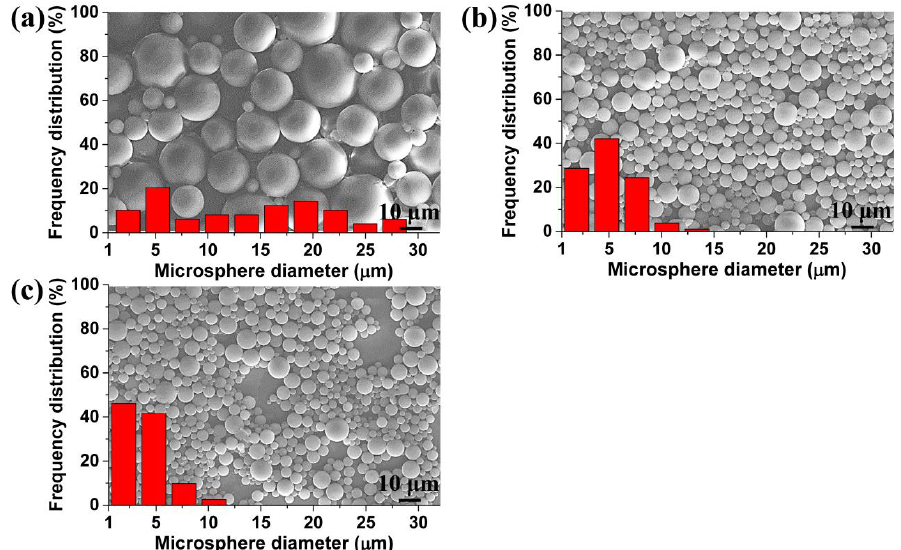
Figure 11. SEM images and size distribution of microspheres in the filtrate, obtained from the membrane with: ( a ) 20.3 μm, ( b ) 11.6 μm, and ( c ) 6.4 μm avera ge cell diameter on the surface. with: ( a ) 20.3 µ m, ( b ) 11.6 µ m, and ( c ) 6.4 µ m average cell diameter on the